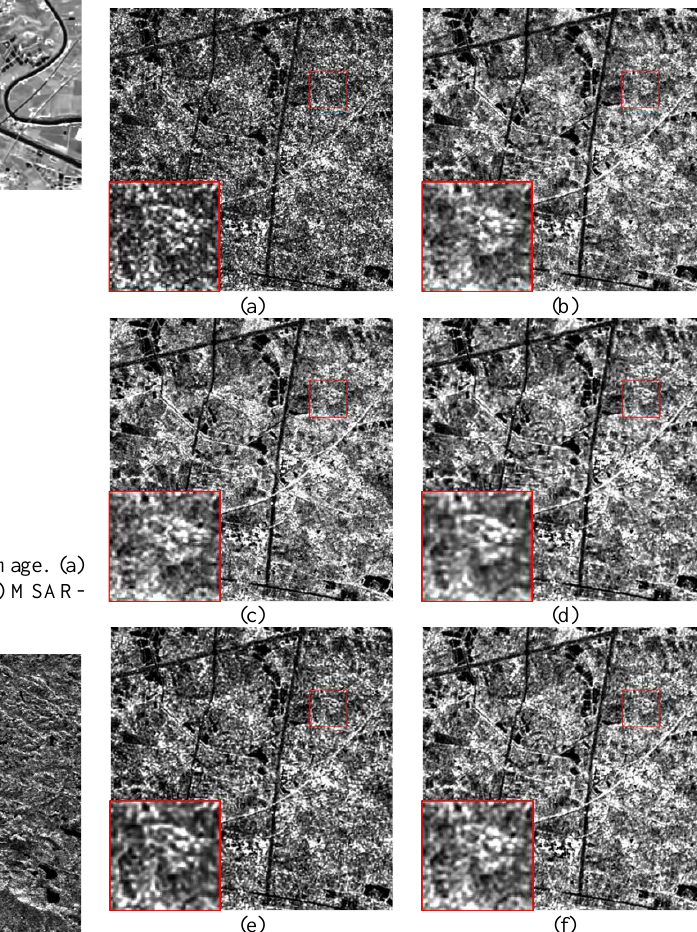
Fig. 6 Despeckled images for the Sentinel-1 GRD-HR image. (a) Noisy image. (b) UTA. (c) NLTF. (d) MSAR-BM3D. (e) RABASAR. (f) the proposed